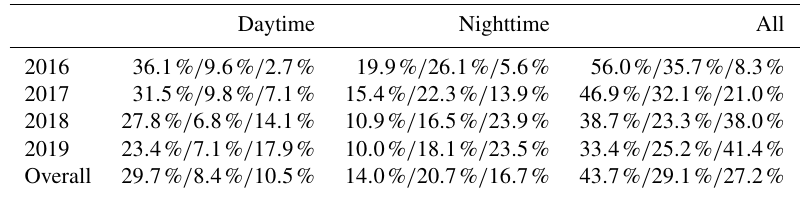
Table 1. Percentage of NEE data with different gap scores (0/1/2) for daytime and nighttime from 2016 to 2019. NEE gaps are classified as non-gaps (gap score: 0), gaps due to low data quality (gap score: 1), and gaps due to electrical and/or instrument failures (gap score: 2).